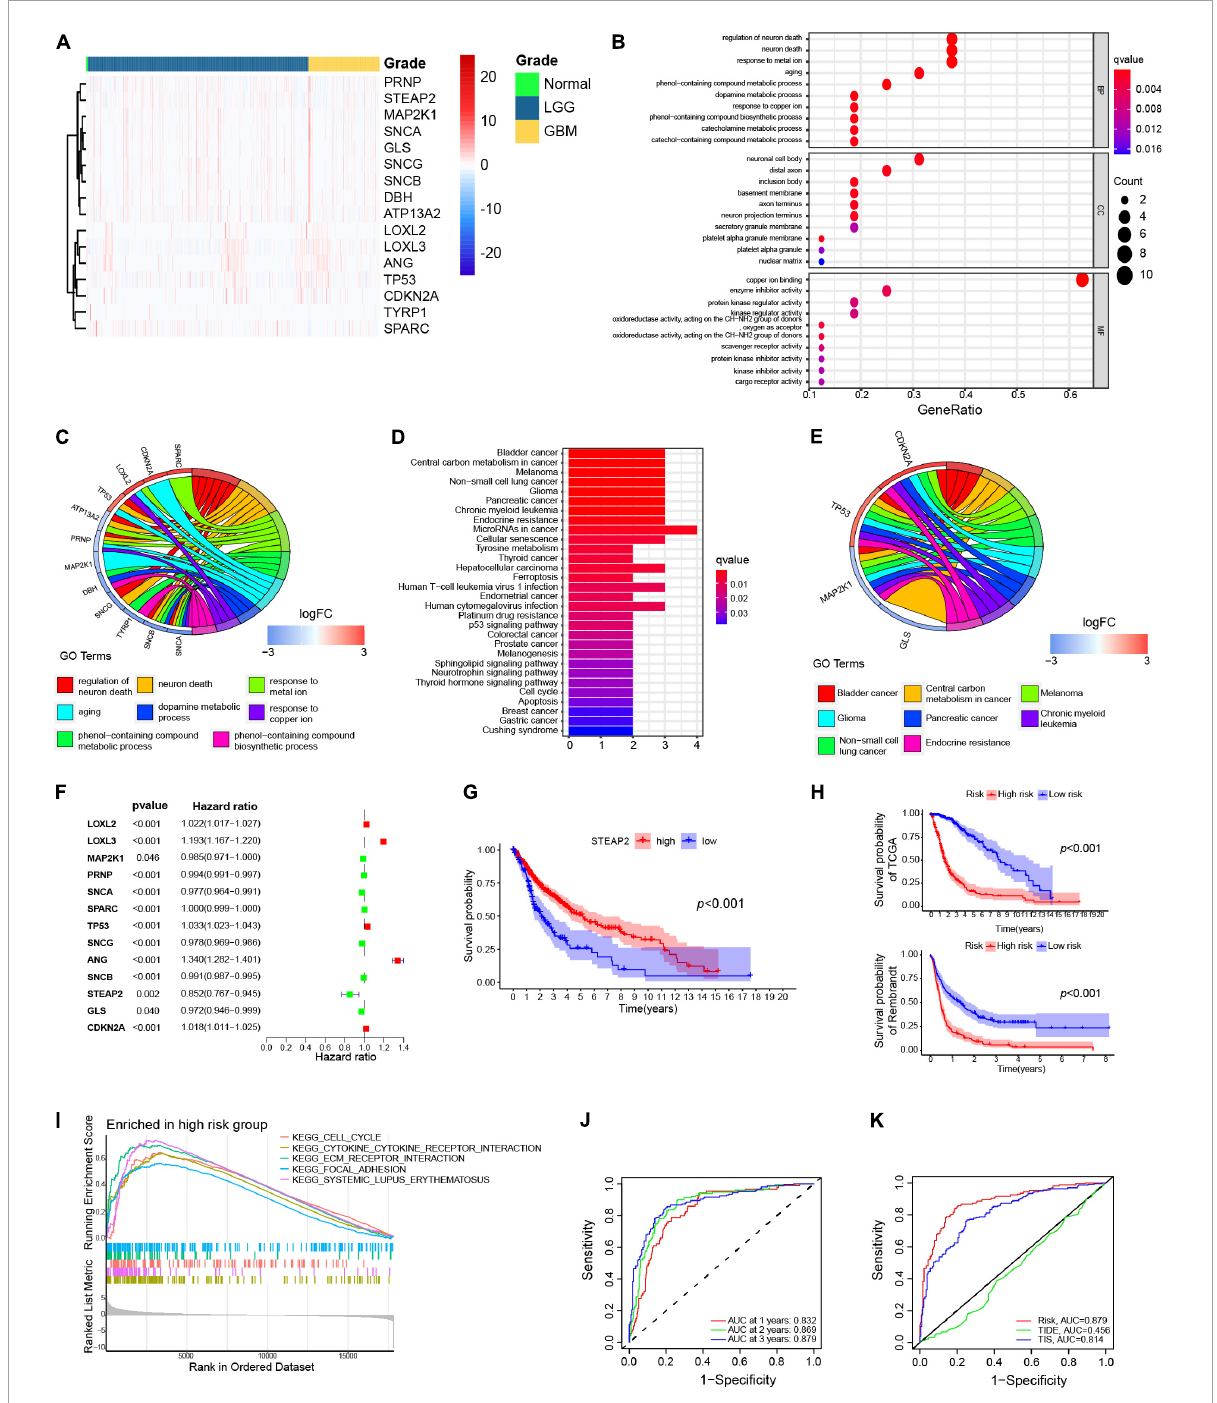
FIGURE2 Differentially expressed copper-related genes in GBM. (A) Heatmap displaying all differentially expressed copper-related genes among 169 GBM samples (orange), 529 LGG samples (blue), and 5 normal tissue samples (green). (B,C) Gene Ontology (GO) enrichment analysis of the differentially expressed copper-related genes ( p < 0.05). (D,E) Kyoto Encyclopedia of Genes and Genomes (KEGG) pathway analysis of differentially expressed copper-related genes ( p < 0.05). (E) Univariate Cox analysis of 13 prognosis-related genes. (F) K–M survival analysis of TCGA samples based on STEAP2 expression ( p < 0.05). (G) K–M survival analysis of the high-risk and low-risk subgroups in TCGA cohort based on the prognostic model. (H) K–M survival analysis of the high-risk and low-risk subgroups in the Rembrant cohort ( n = 356) based on the prognostic model. (I) Gene sets enriched in the high-risk subgroup ( p < 0.05 and FDR < 0.25). (J) ROC curve for 1-, 2-, and 3-year survival of the prognostic model in TCGA cohort. (K) Comparison of different prognostic